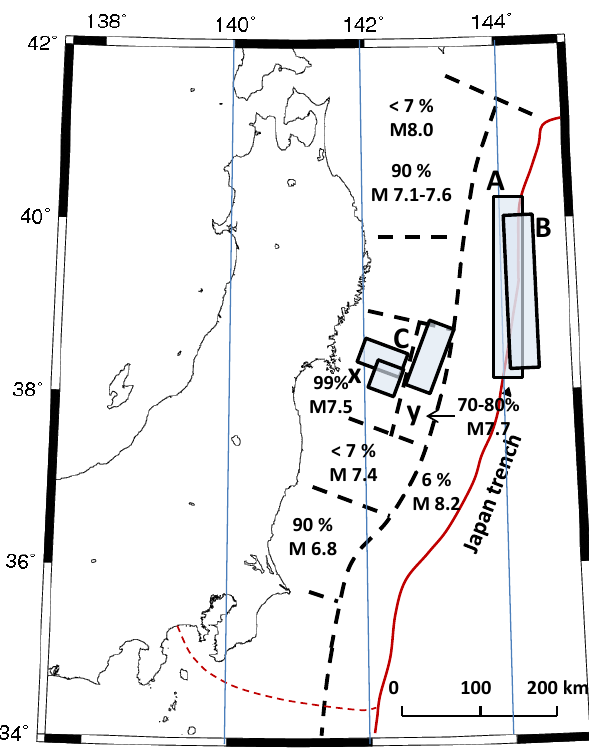
Fig. 7. Forecasted fault segments on the plate interface near the To- hoku region between 35 ◦ and 41 ◦ N (Headquarters for Earthquake Research Promotion – HERP, 2002; { 13 } No. 13 in Table 1). Among the eight segments, five ruptured during the 2011 Great East Japan Earthquake. The 30yr probability and the magnitude estimated by HERP are given on the map. The rectangles A, B and C show the fault planes for the three scenario earthquakes, similar to the 1896 Sanriku earthquake, the 1933 Sanriku earthquake, and the Com- pound Offshore Miyagi prefecture earthquake, respectively, near Iwate and Miyagi